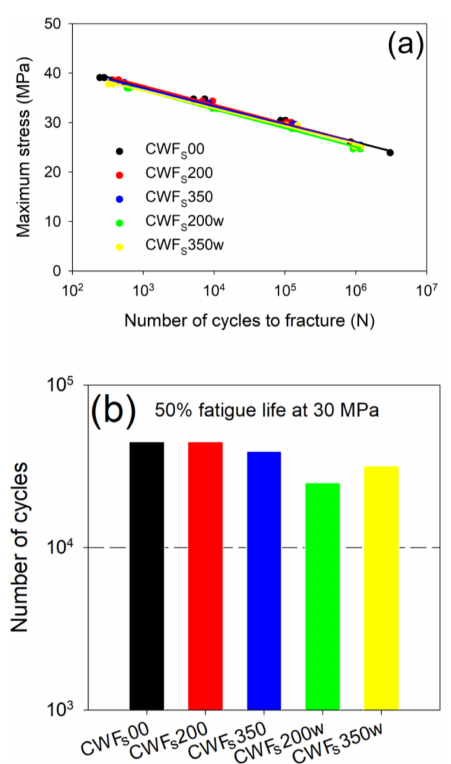
Figure 6. ( a ) S − N curves and ( b ) half-fatigue life of CWF S type composites: CWF S 00, CWF S 200, CWF S 350, CWF S 200w, and CWF S 350w.